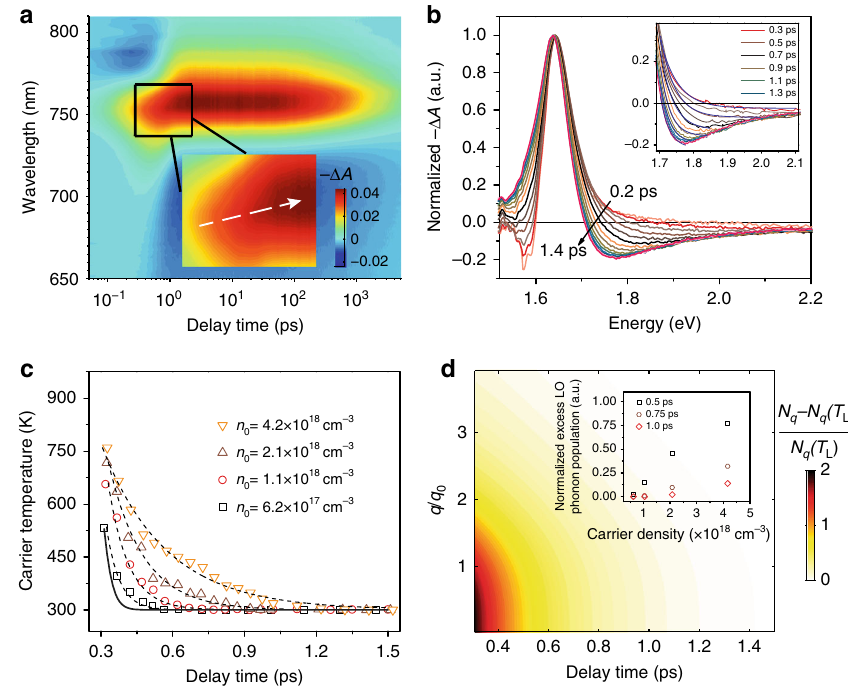
Fig. 1 TA spectra and HC cooling dynamics. a Representative pseudo-color TA spectra plot of MAPbI 3 fi lms excited at 2.48 eV with initial carrier density n 0 of 4.2 × 10 18 cm − 3 . The peak intensity red-shifts with increasing time delay from 0.1 to 1.5 ps (inset — white dotted arrow as a guide to the eye). b Normalized TA spectra extracted from a with variable delays from 0.2 ps to 1.4 ps and the inset shows the representative fi tted high energy tails using the Maxwell – Boltzmann distribution function to extract the HC temperature. c Extracted HC temperature with delay at different carrier density. Black line: calculated HC cooling dynamics in the absence of hot-phonon effect. All the dashed lines are calculated HC cooling dynamics in the presence of hot- phonon effect (see main text). d Pseudo-color plot of calculated relative non-equilibrium hot LO phonon distribution (i.e., [ N q − N q ( T L )]/ N q ( T L )) as a function of normalized phonon wave vector q / q 0 and delay time for n 0 of 4.2 × 10 18 cm − 3 . Inset shows the carrier-density-dependent hot LO phonon ffiffiffiffiffiffiffiffiffiffiffiffiffiffiffiffiffiffiffiffiffi p population with a typical phonon wave vector q ¼ q 0 ¼ 2 m e ω LO = (cid:1) h at delays of 0.5, 0.75, and 1.0